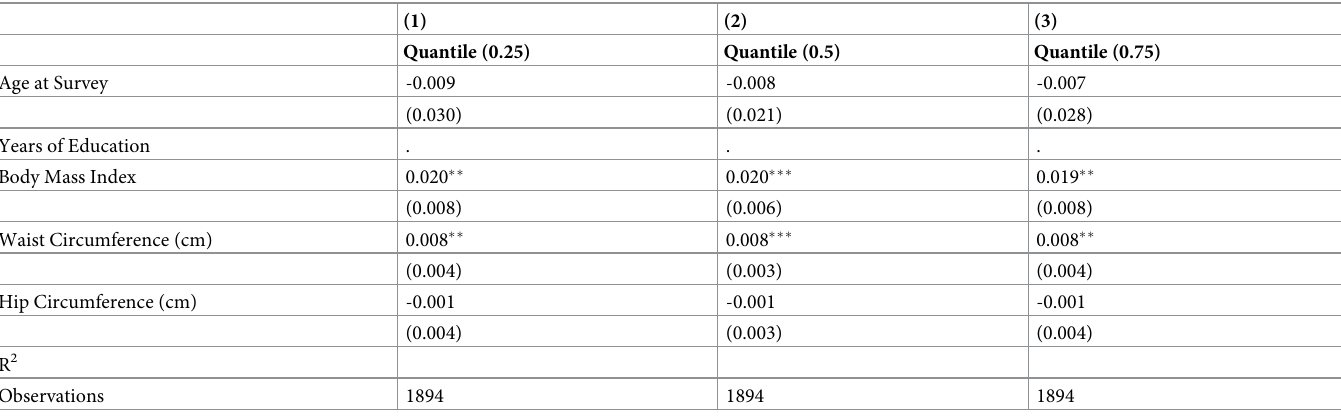
Table 4. Quantile regression